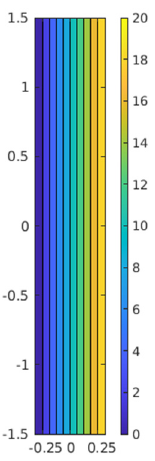
Figure 8. Image of temperature in the shield in State 2.